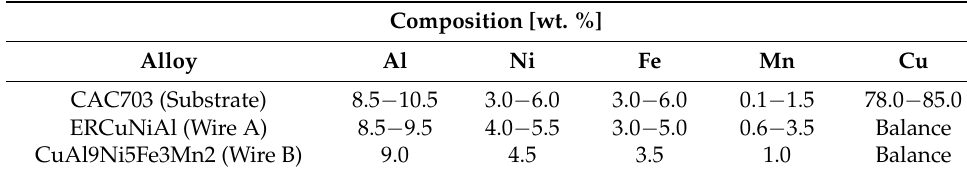
Figure 1. Wire arc additive manufacturing (WAAM) system adopted in the experiment. Table 1. Chemical compositions and mechanical properties of materials (wt. %) Composition [wt. %]